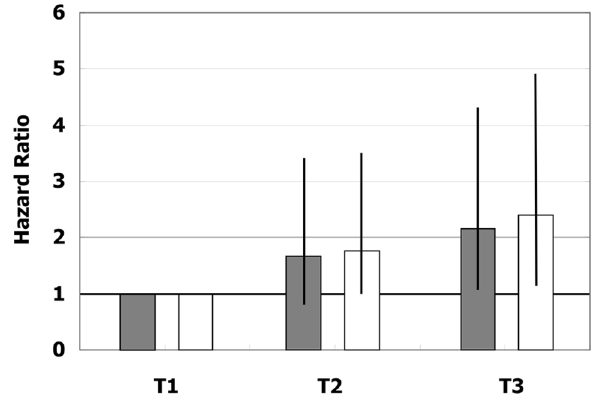
Figure 2. Hazard ratios of Cox regression models among the tertiles of plasma BNP in subjects with AF. Grey bars = age-sex adjusted model; White bars = multivariate model .